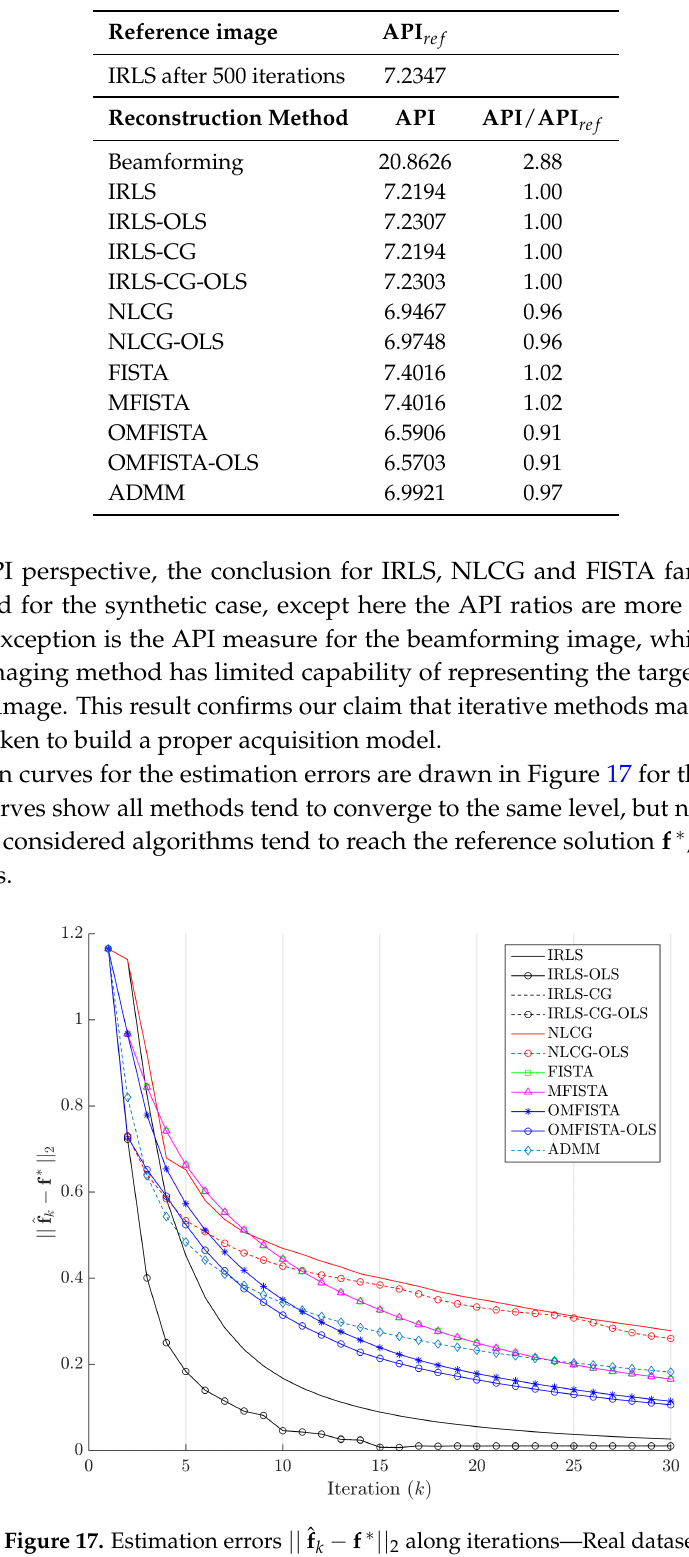
Table 3. API values for reconstructed images after 30 iterations - Real dataset